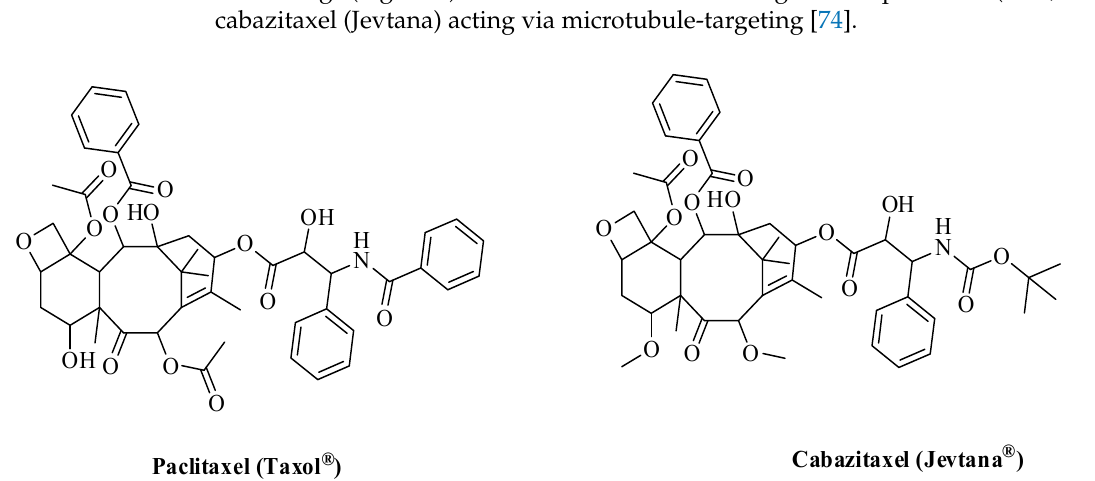
Figure 9. FDA-approved oxygen-based anti-angiogenics.